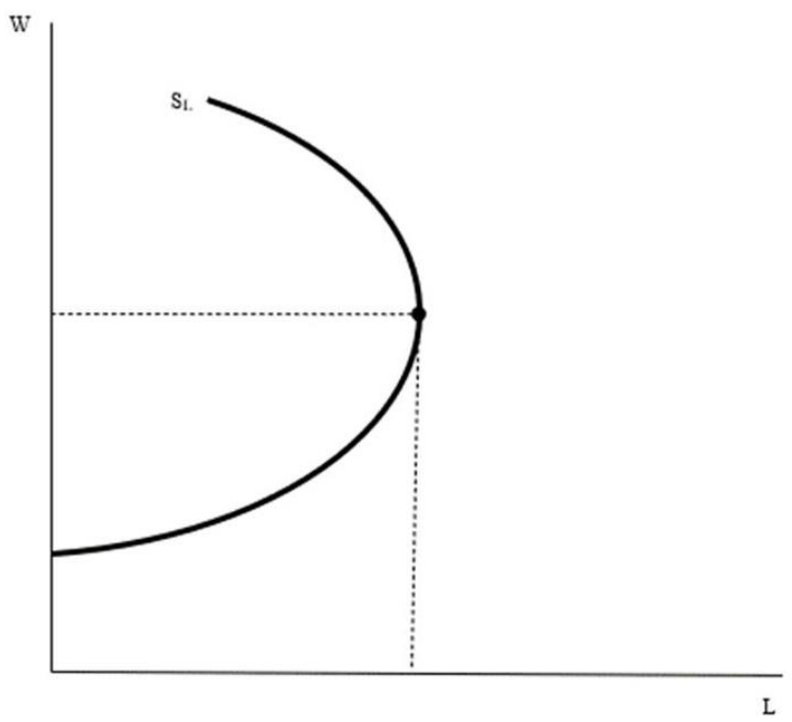
Figure 2. The backward-bending labor supply curve.